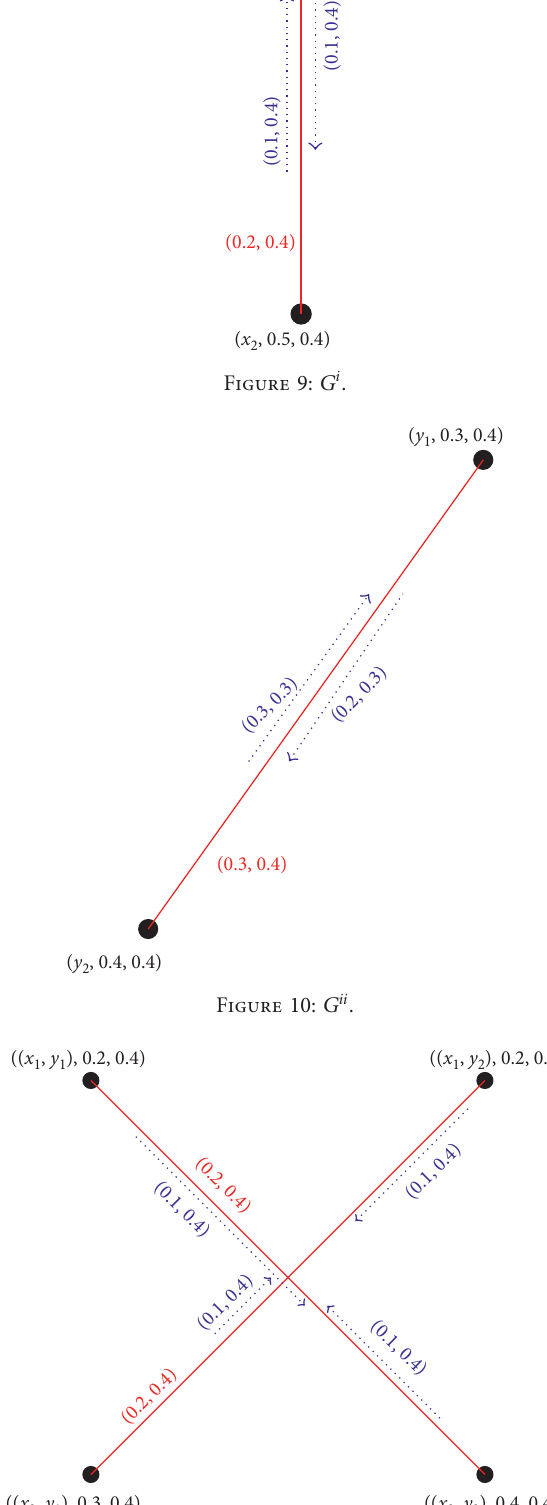
Figure 11: TP of IFIGs given in Figures 9 and